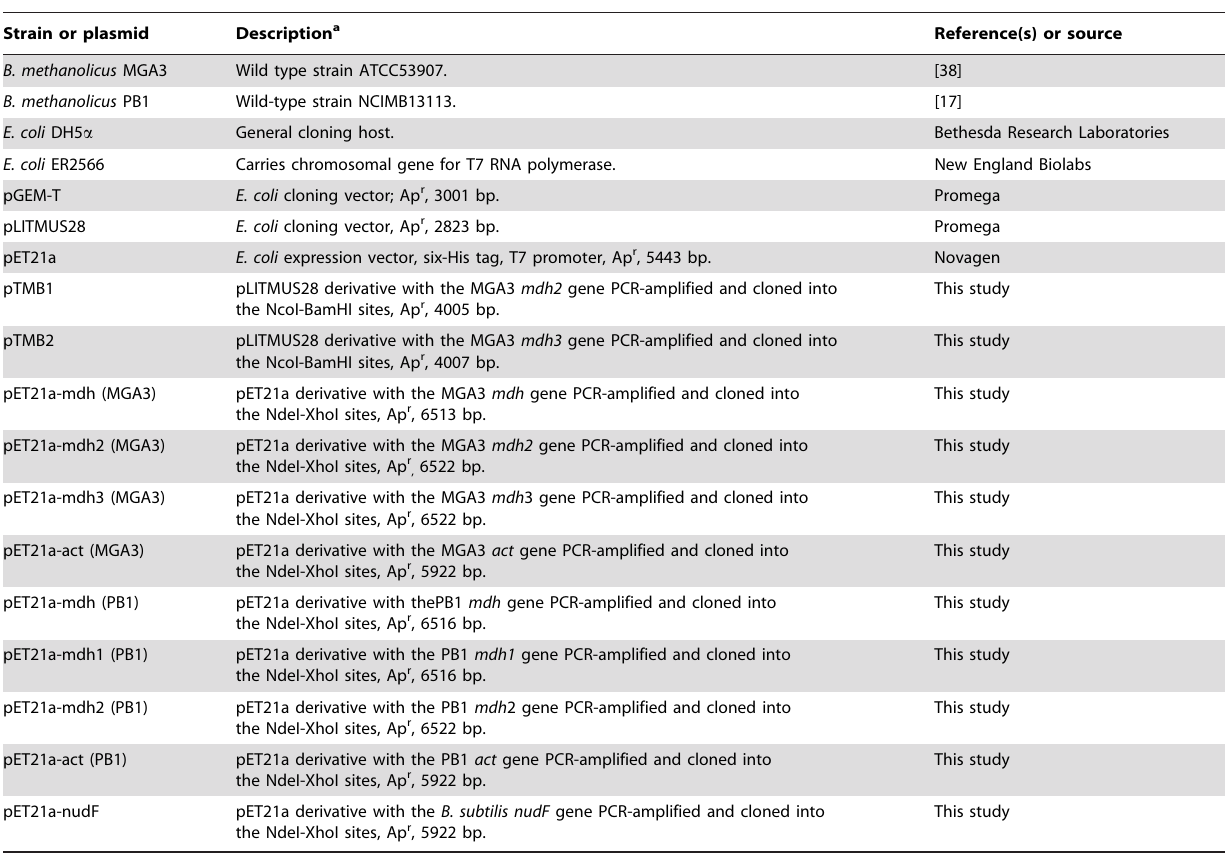
Table 1. Bacterial strains and plasmids used in this